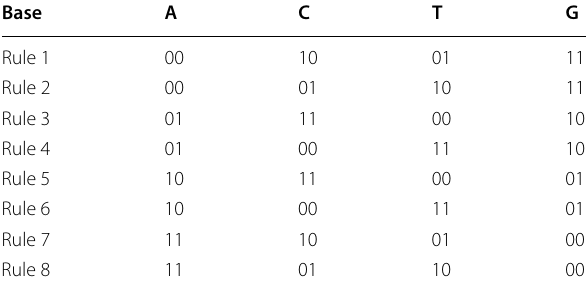
Table 1 RSA procedures Table 2 DNA encoding